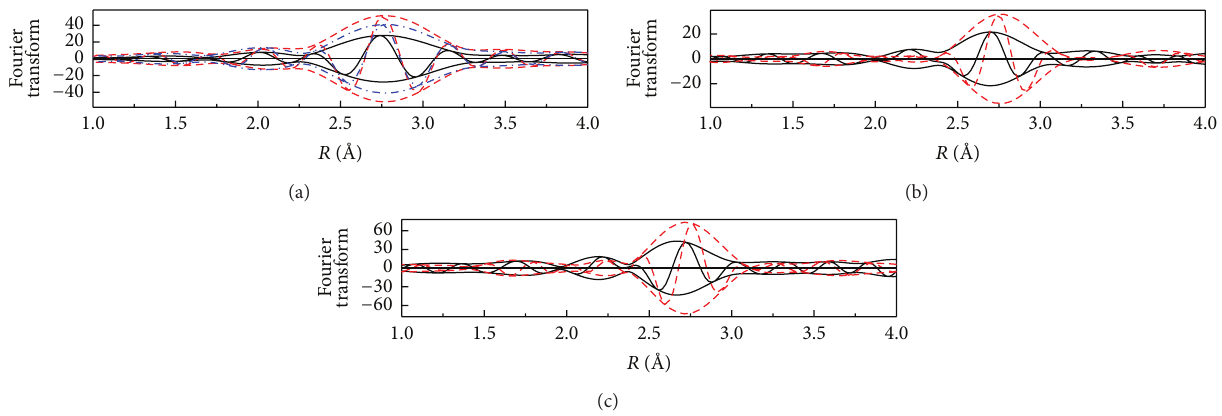
Figure 8: TPR profiles for 𝛾 -Al 2 O 3 supported catalysts: (a) Re/ 𝛾 -Al 2 O 3( line); (b) Pd(OAc) 2 / 𝛾 -Al 2 O 3 (orange line), Pt/ 𝛾 -Al 2 O 3 (olive line), and Pt-Pd(OAc)/ 𝛾 -Al 2 O 3 (magenta line).